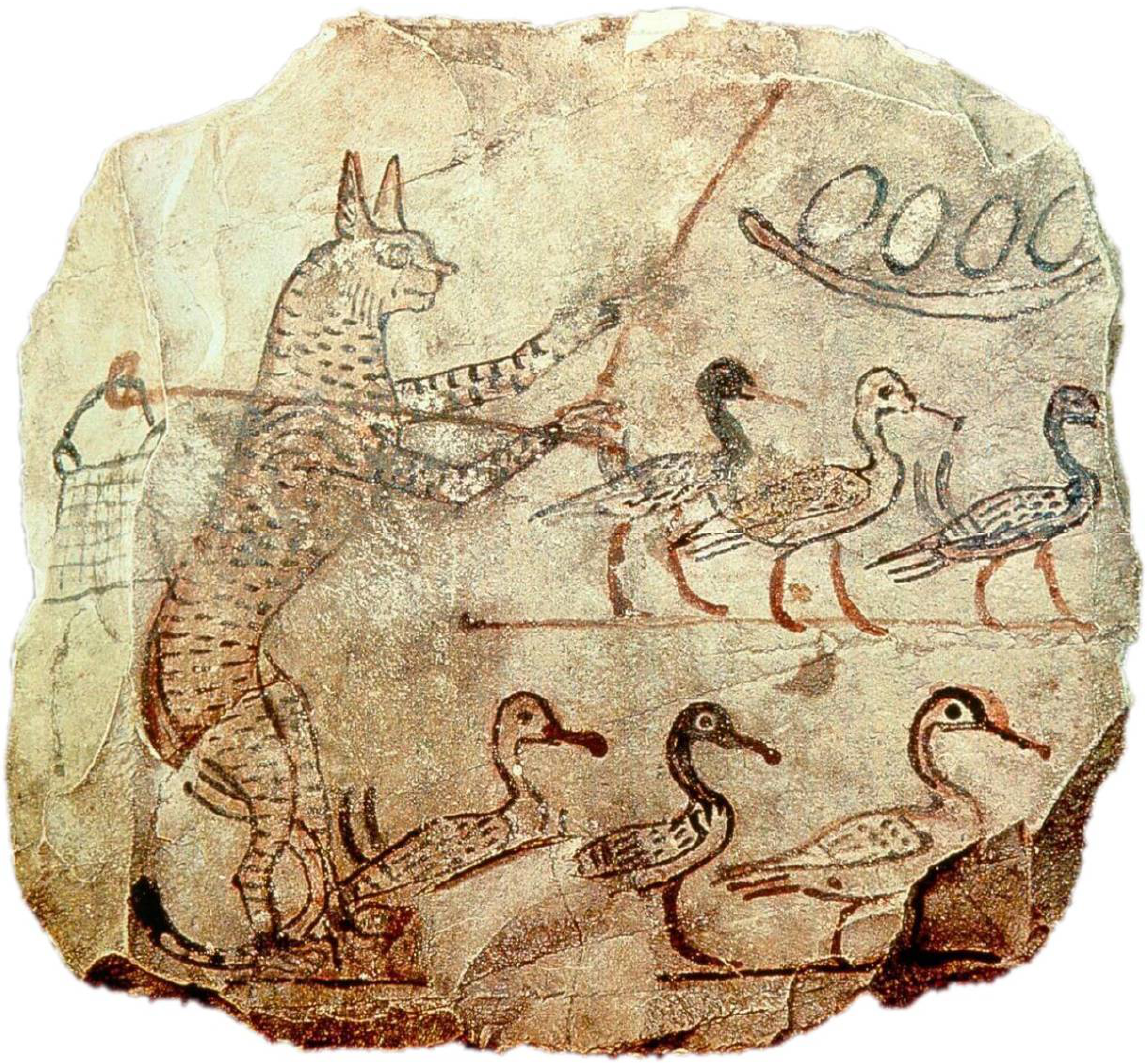
Figure 2. Cat herding geese (MM inv. no. 14051), limestone flame, Deir el-Medina, Ramesside period (Image courtesy of the Medelhavsmuseet, Stockholm).